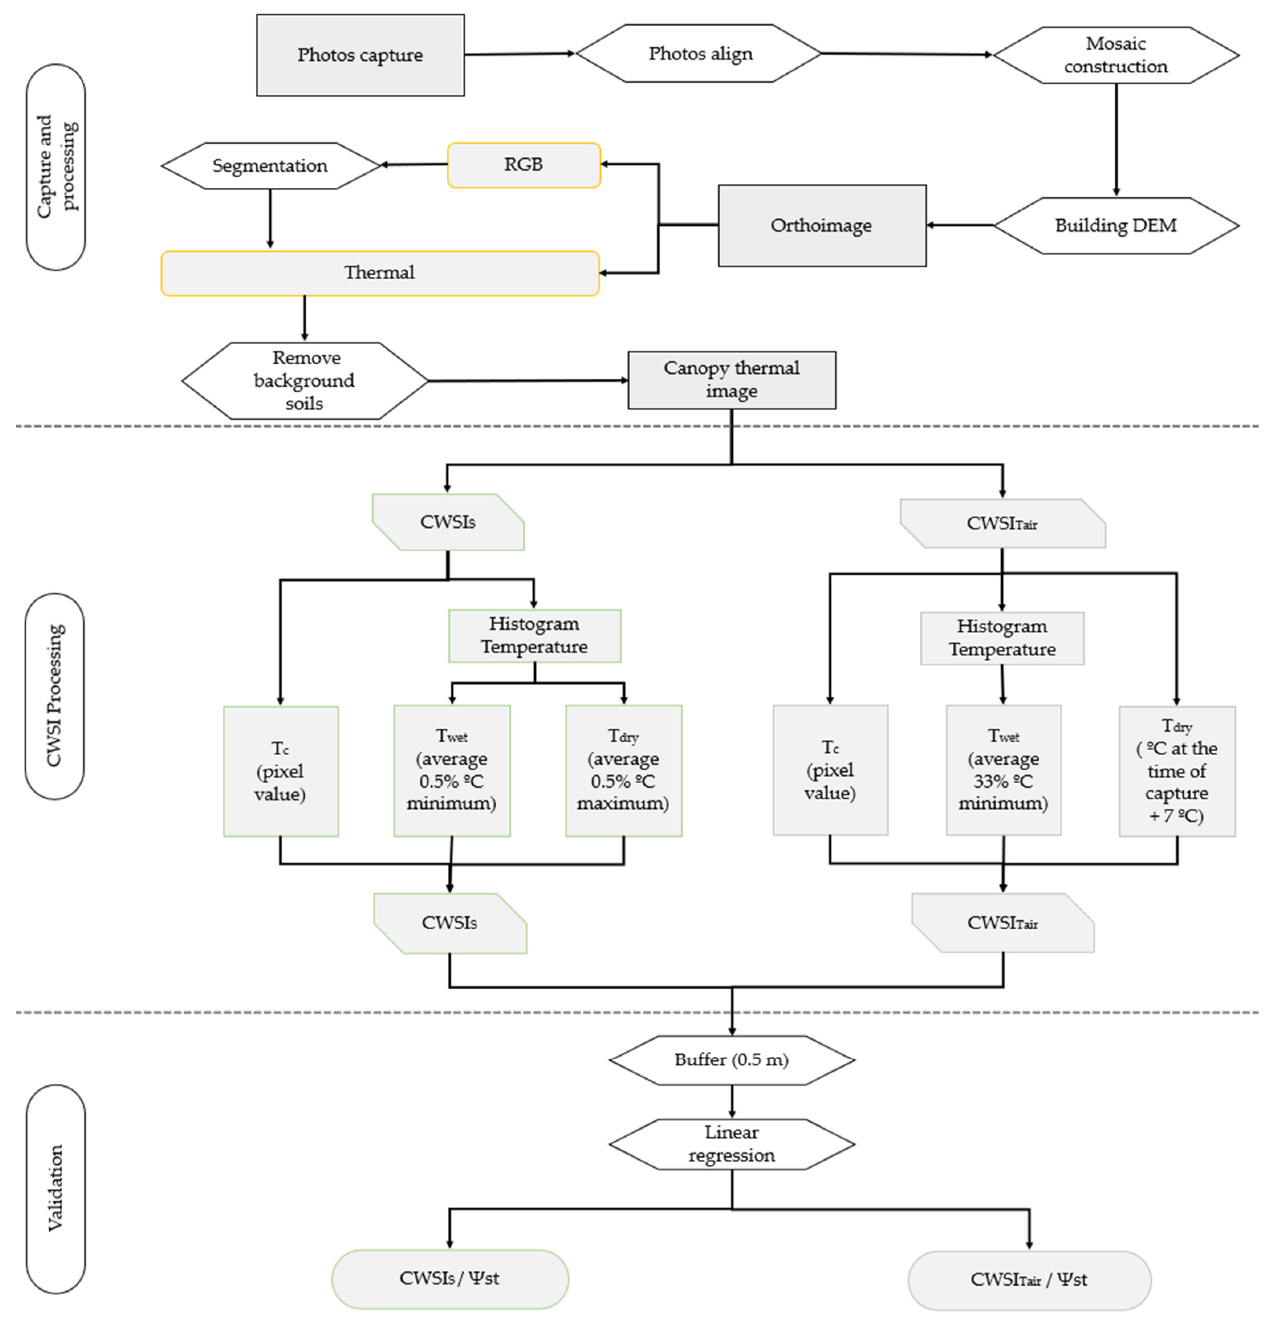
Figure 2. Flow diagram for calculating CWSI S and CWSI Tair and their spatialization.